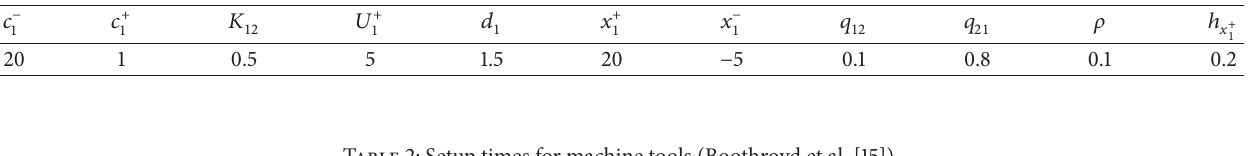
Table 2: Setup times for machine tools (Boothroyd et al. [15]).